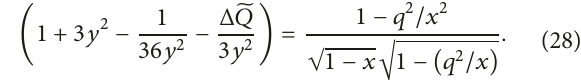
black hole radius is the same in two different types of space- time, while (21) shows the critical value of the RN-AdS black hole is dependent on AdS length scale 𝑙 . Therefore, when the horizon position 𝑟 + and charge 𝑄 are given for such black hole, the radiation temperature depends on the cosmological constant. On the other hand, it can be seen from (13) that when 𝑞 and 𝑥 are fixed, the temperature of RN black holes depends on the cavity radius 𝑟 𝐵 .